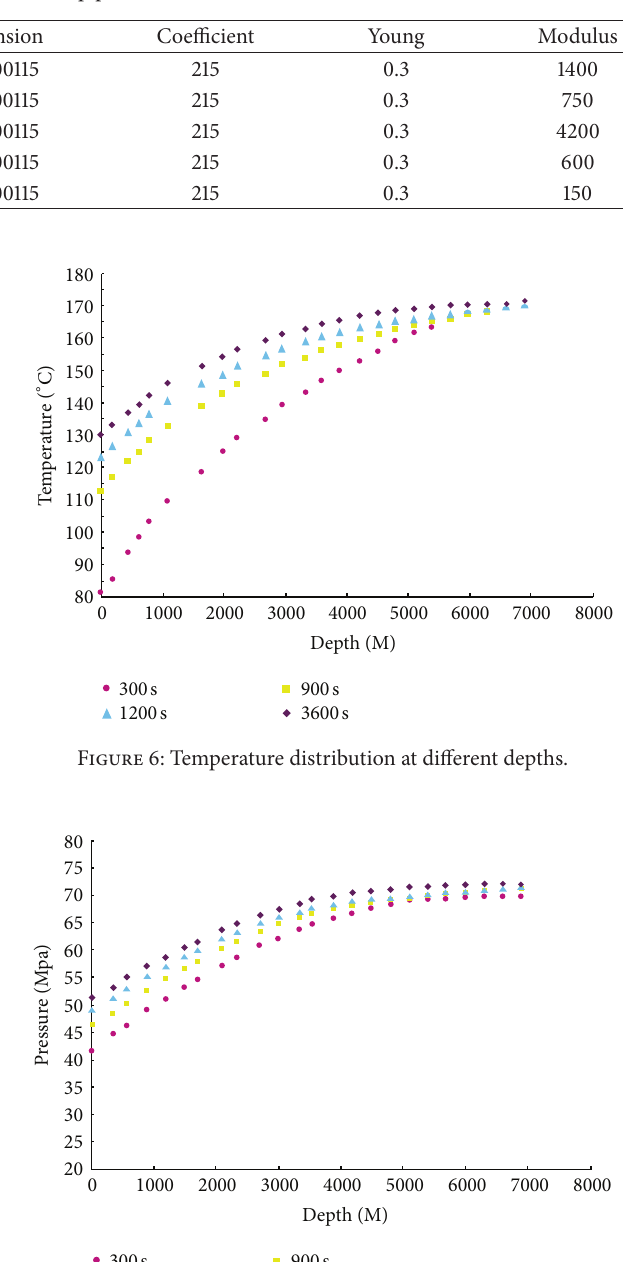
Table 1: Parameters of pipes.